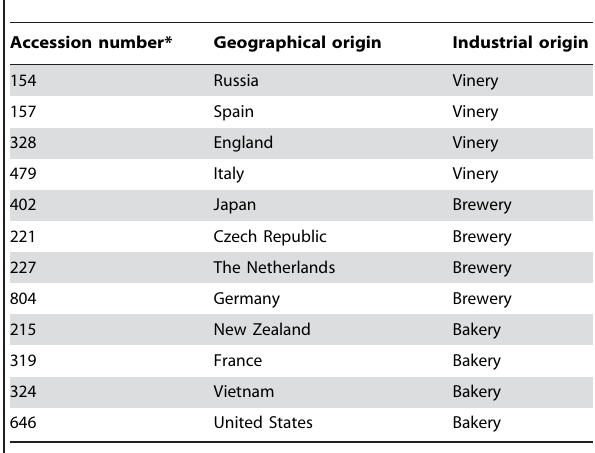
Table 1. Collection of strains of Saccharomyces cerevisiae